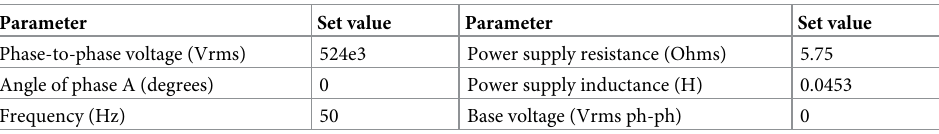
Table 1. The three power supplies’ parameter settings.